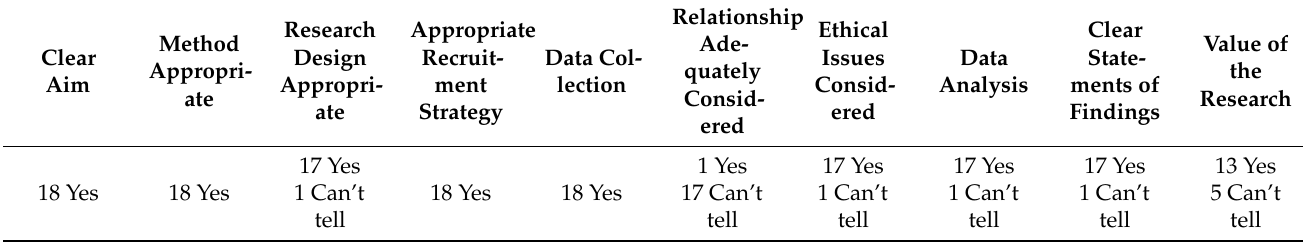
Table 3. Overall presentation from the assessment of methodological quality of the 18 included